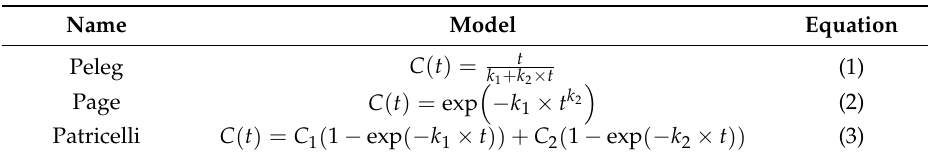
Table 2. Equations of mathematical models employed.